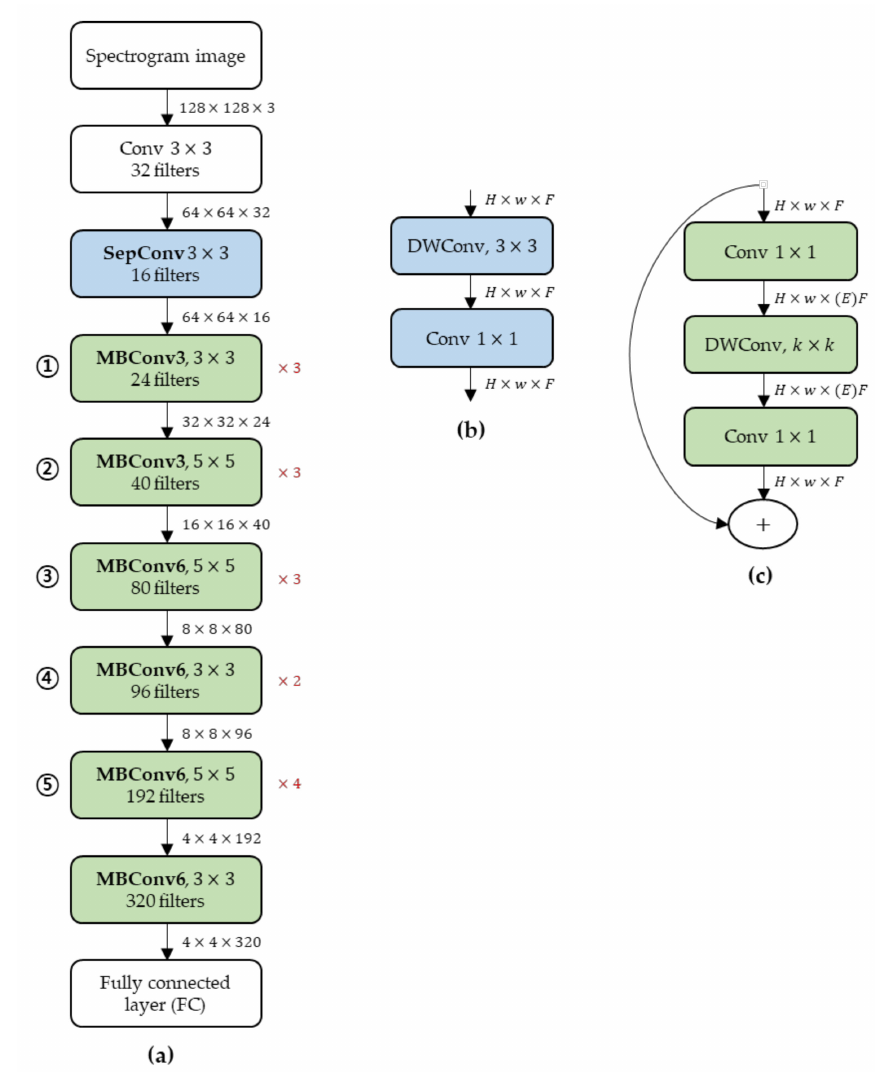
Figure 3. MnasNet architecture for pig abnormality classification: ( a ) MnasNet: 8-bit filters clustering algorithm applied to all layers; ( b ) SepConv; and ( c ) MBConv(E), k × k